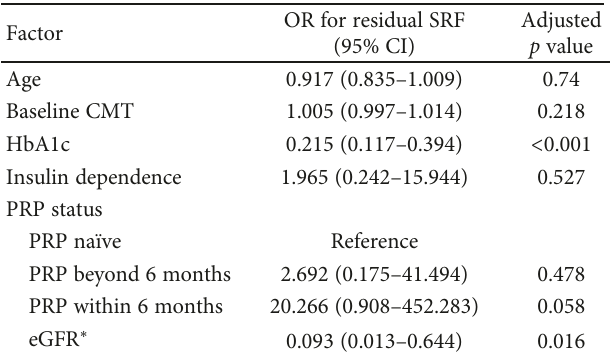
Table 5: Correlating factors for residual subretinal fl uid after